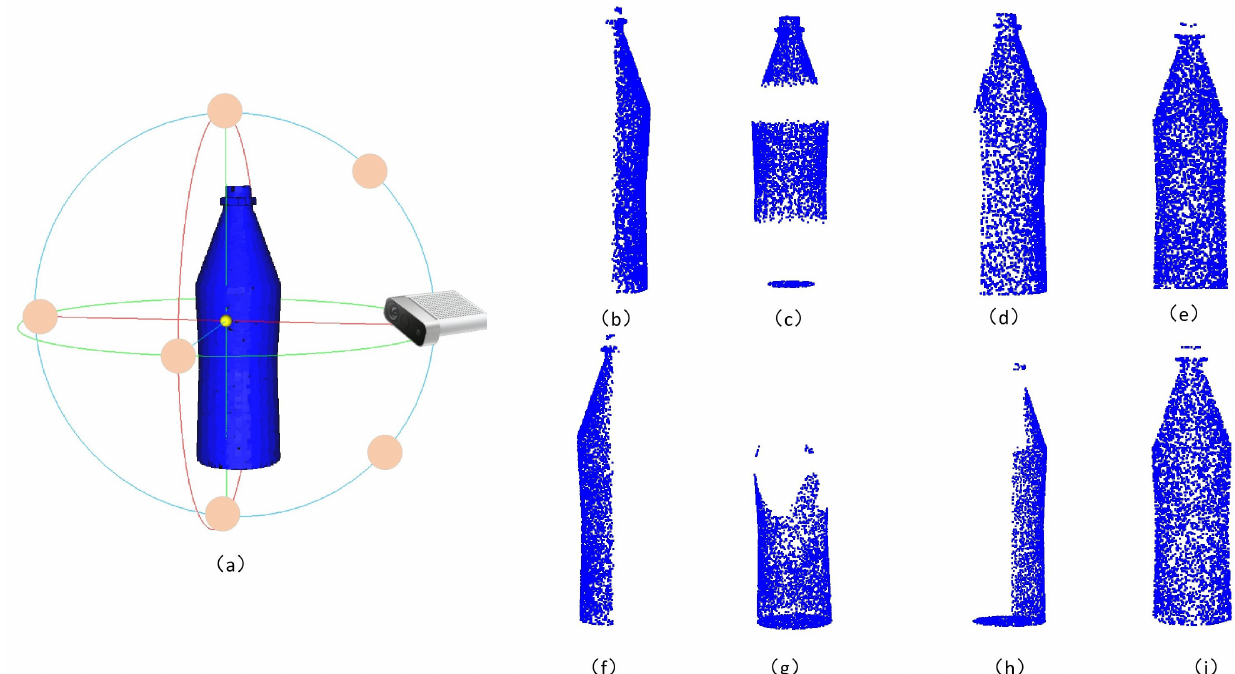
Figure 5. Figure ( a ) shows the camera poses around the complete 3D point cloud. Figure ( b – i ) represent the partial point cloud generated by different camera